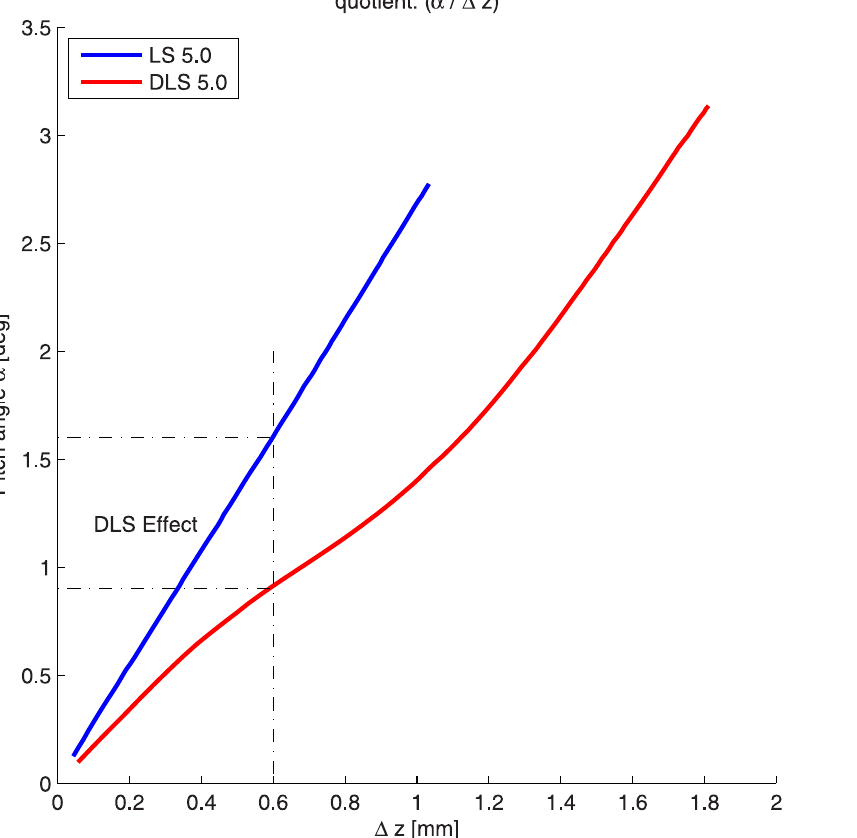
Figure 9. With the same pitch angle of the osteosynthesis plate, interfragmentary motion is higher using the DLS than the LS.